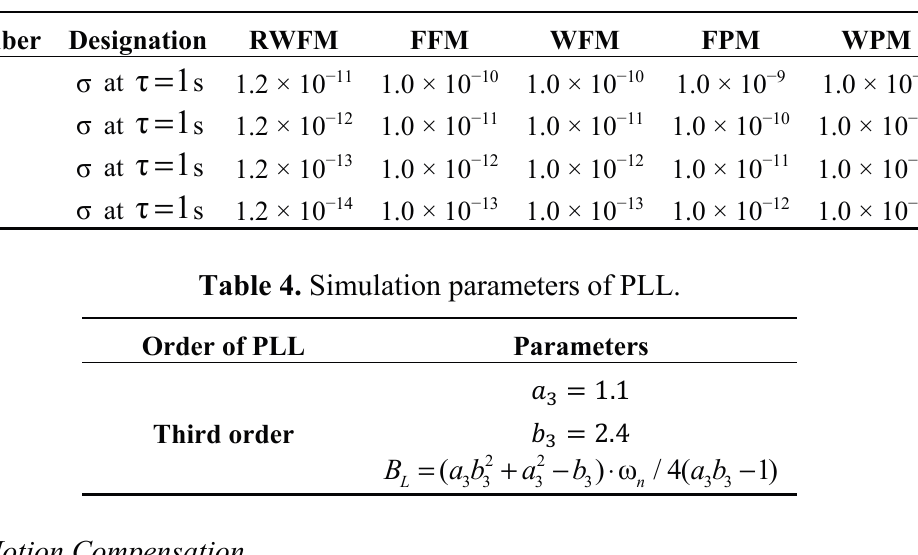
Table 3. Allan deviation of each phase noise component at (cid:2028) = 1 s.